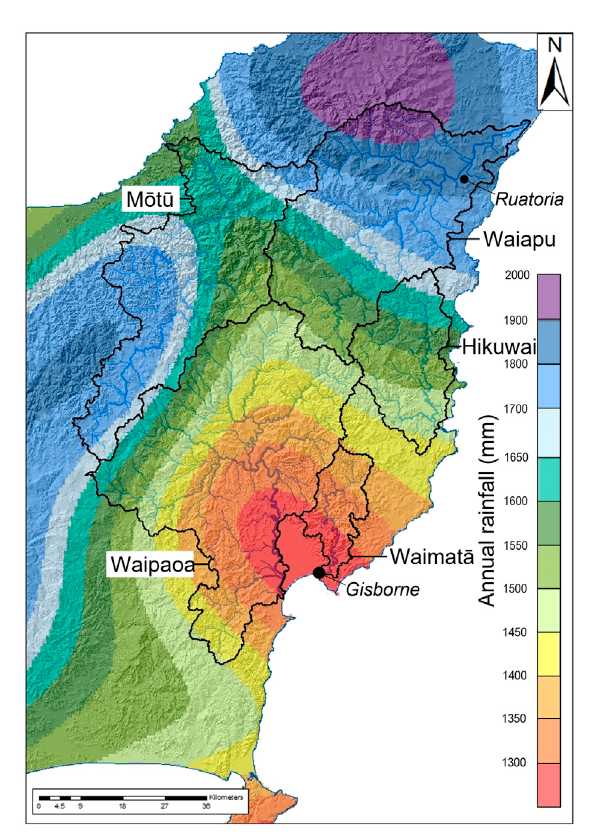
FIGURE 2 Averageannualrainfall(mmyr -1 )forTair ā whiti(EastCoastRegion of Aotearoa New Zealand) from 1981 – 2020. Note the pronounced gradient from north to south, with much higher annual totals in the Waiapu Catchment relative to the Waimat ā Catchment. However, these annual totals mask similarity in the prevalence of the geomorphic role of high intensity storms across the entire region.